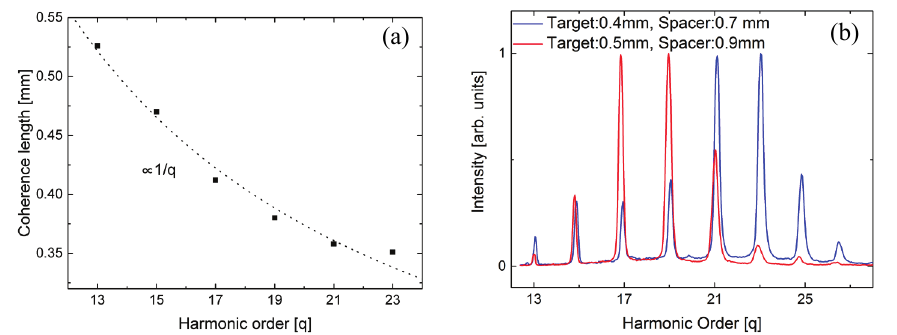
Fig. 1. Experimentally determined coherence lengths for different harmonic orders (a). Intensity of different harmonic orders employing different disk widths and spacing